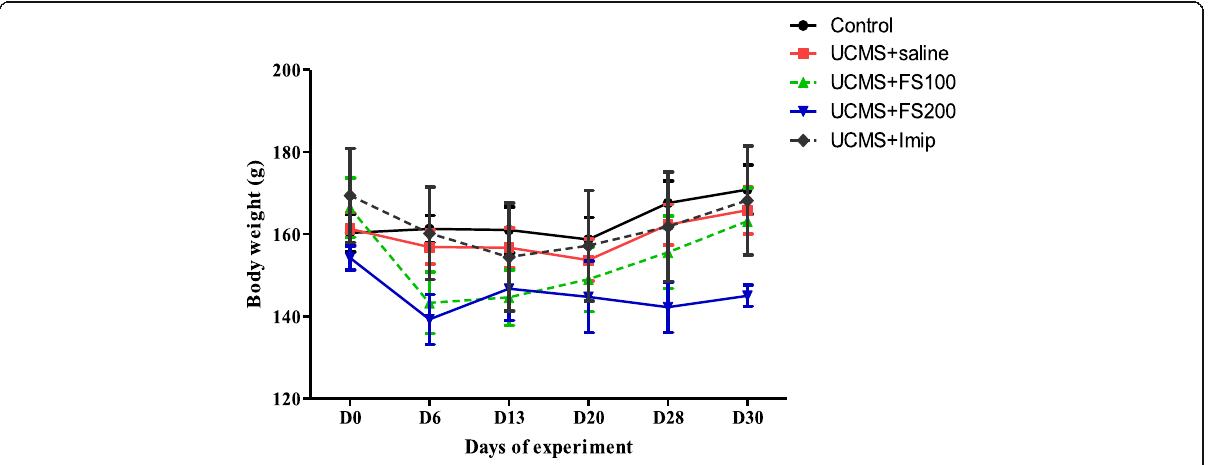
Fig. 4 Effect of hydromethanolic extract of F. sycomorus on body weight (g) in rat